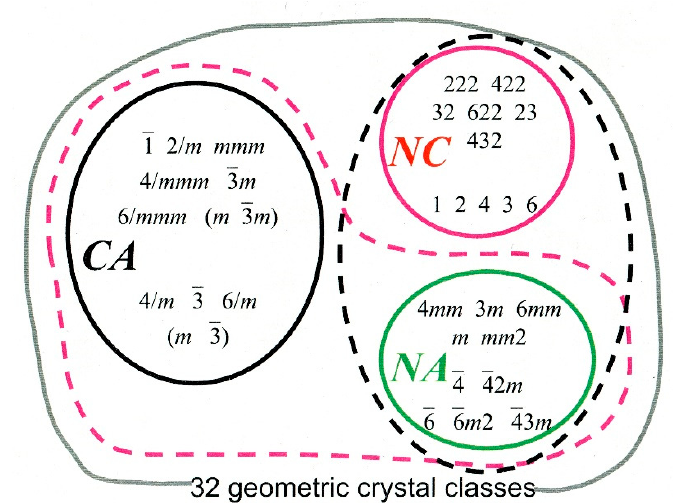
Figure 2. The 32 geometric crystal classes. CA means Centrosymmetric & Achiral, NA means Non- centrosymmetric & Achiral, NC means Non-centrosymmetric & chiral. Note that the symbols in the achiral classes contain either an m, 4(cid:3364) or 6(cid:3364) operator, allowing pairs of enantiomers to be related by a chirality-inverting symmetry operation which is not a centre of symmetry. Figure by courtesy of Evelyne Flack [16].